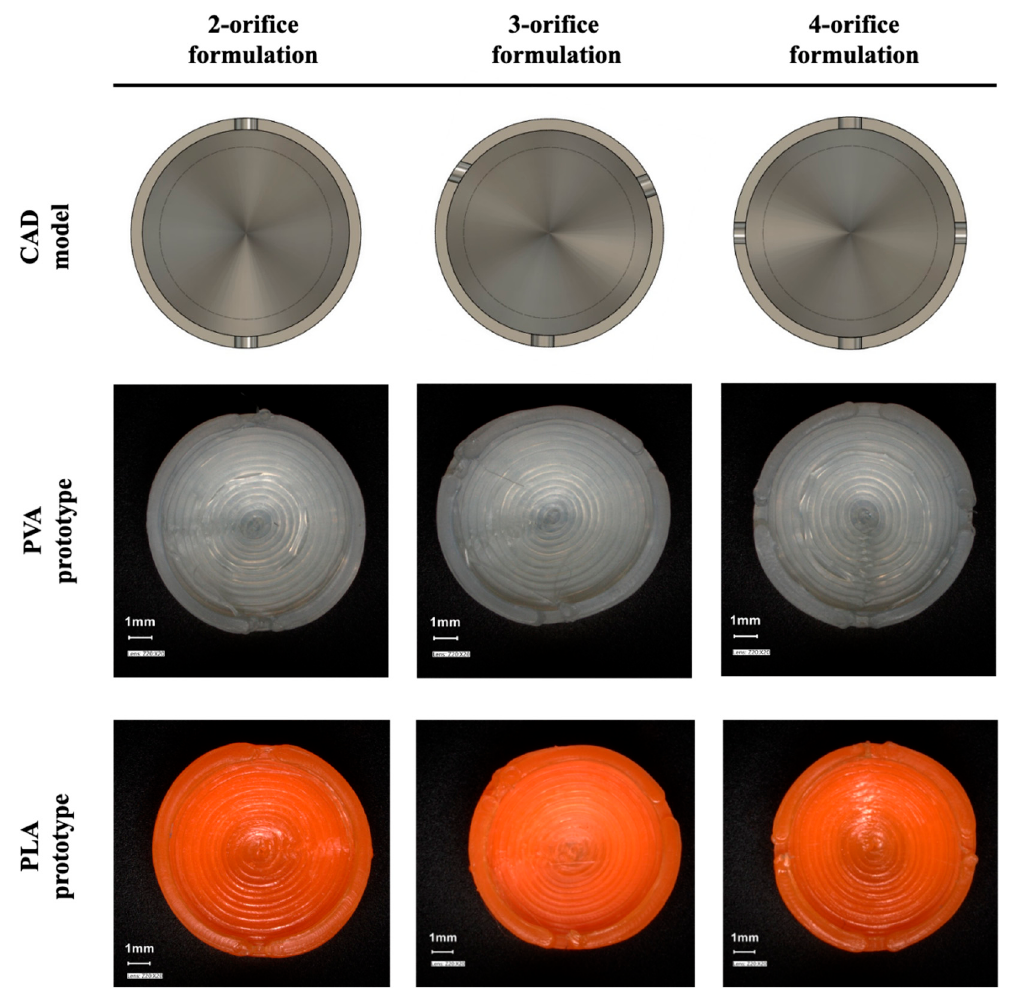
Figure 2. CAD models and digital microscopic images of PVA and PLA-based prototype with multiple orifices.